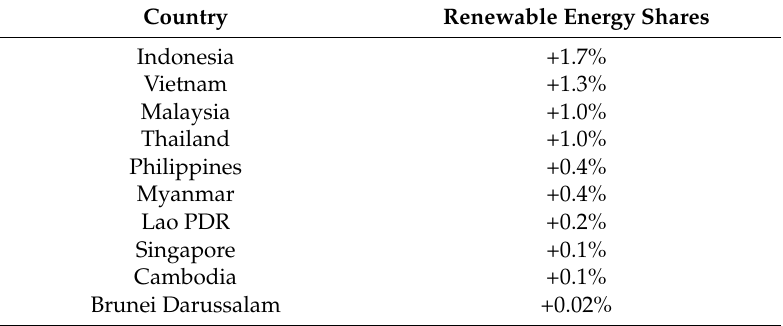
Table 1. Contribution toward increasing ASEAN’s renewable energy share to 23.2%